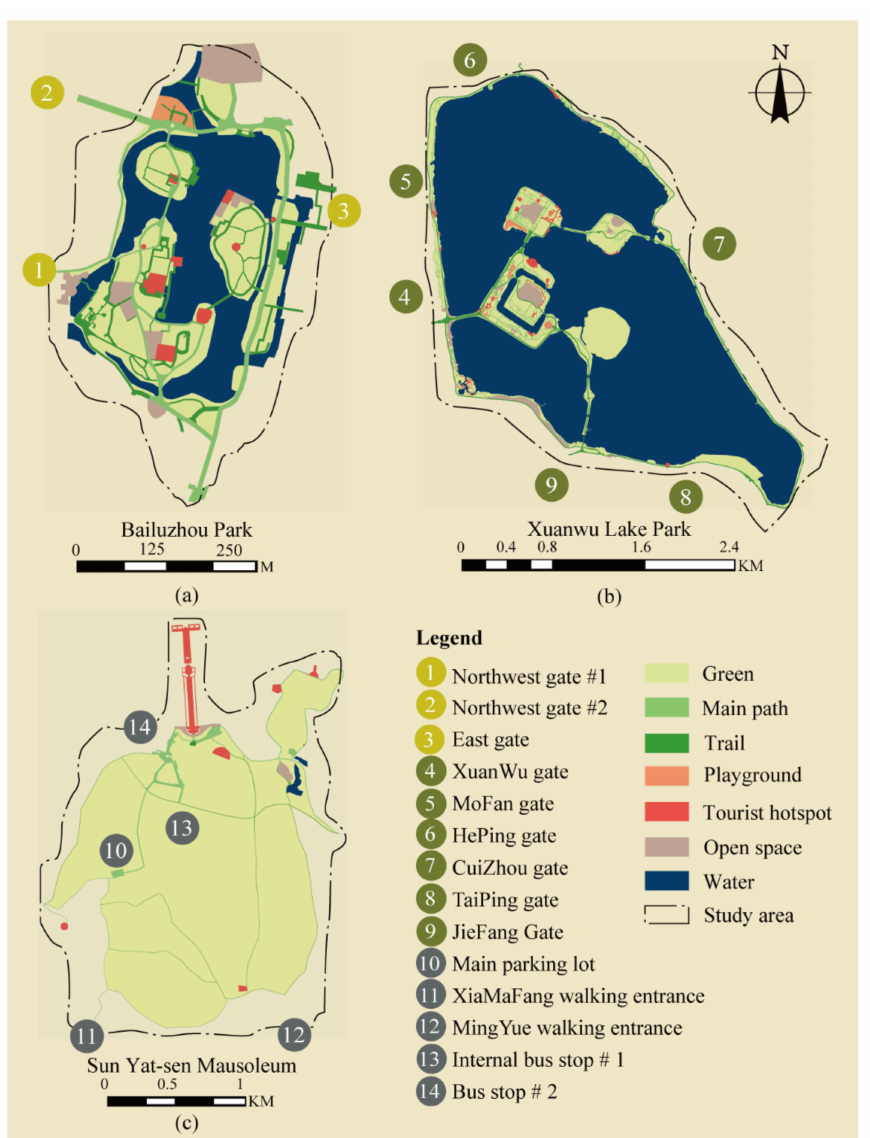
Figure 3. Parks Layouts. ( a ) is the layout of Bailuzhou Park; ( b ) is the layout of Xuanwu Lake Park; ( c ) is the layout of Sun Yat-sen Mausoleum. Copyright 2020 © Author, all rights reserved, used by